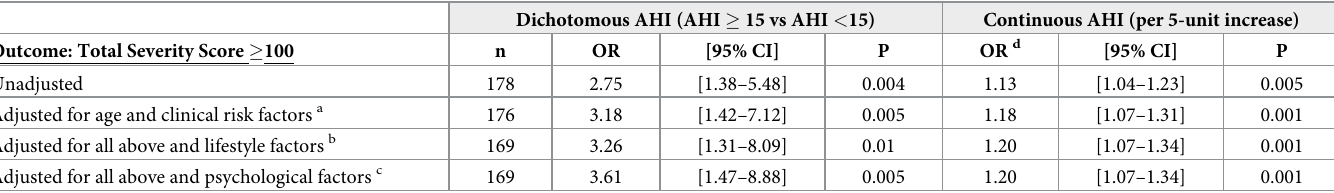
Table 3. Multivariable analysis of the relationship between the Apnea-Hypopnea Index (AHI), both as a dichotomous variable (AHI � 15) and as a continuous vari- able, and total severity score � 100, in the overall sample with twins treated as individuals. Dichotomous AHI (AHI � 15 vs AHI <